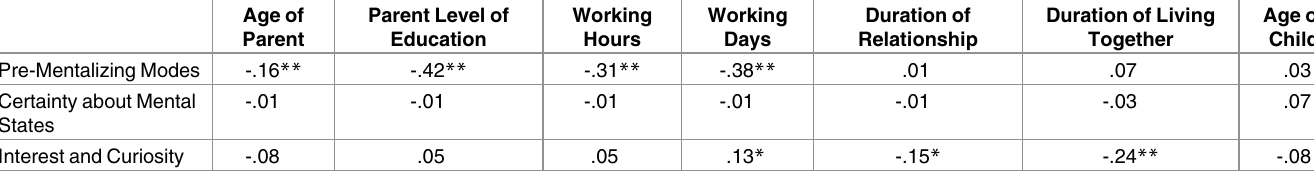
Table 2. Correlations among the PRFQ subscales and demographic featuresin Study 1.